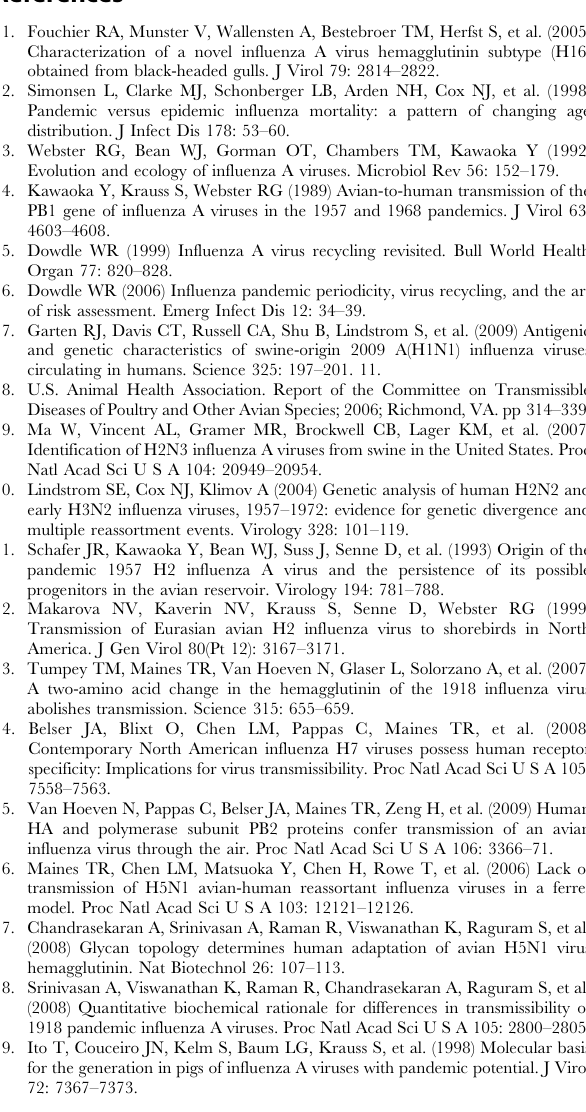
Table S1 Composition of the receptor binding amino acids present in the hemagglutinin of H2N2 viruses used in this study and their receptor binding specificity. The viruses were assayed by hemagglutination using resialylated turkey red blood cells (RBCs).